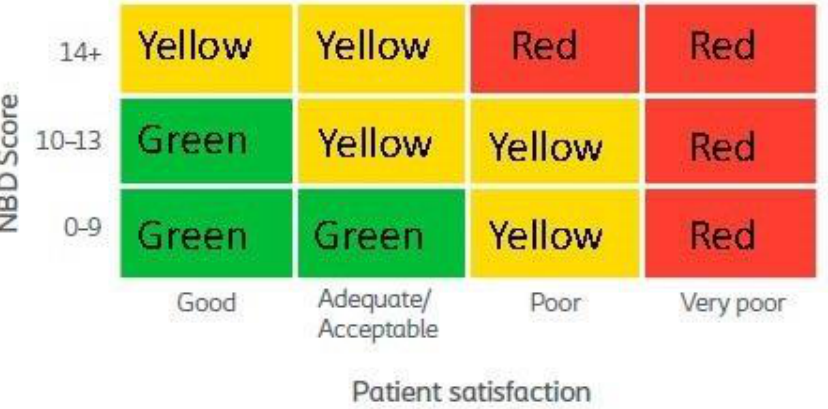
Figure 1. The MENTOR (Monitoring Efficacy of NBD Treatment On Response) grid to determine treatment assessment outcome. Green “Monitor”, Yellow “Discuss” and Red “Act.”